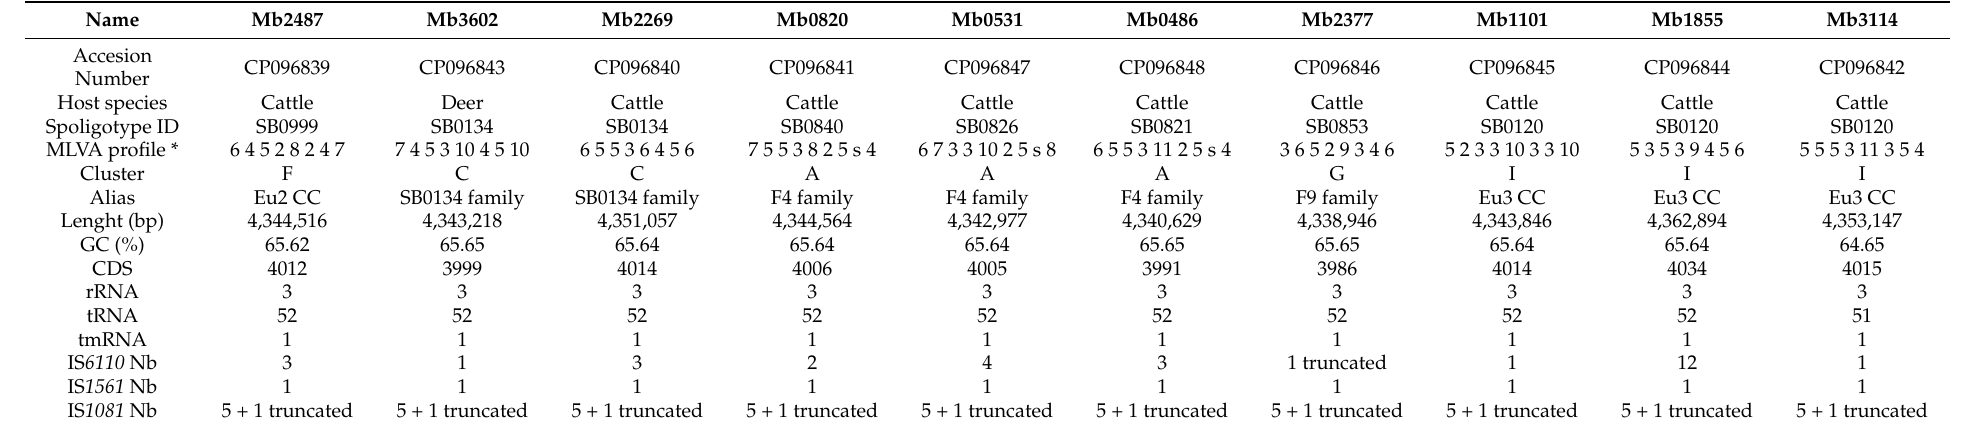
Table 1. Information on the 10 M. bovis strains selected and sequenced in this